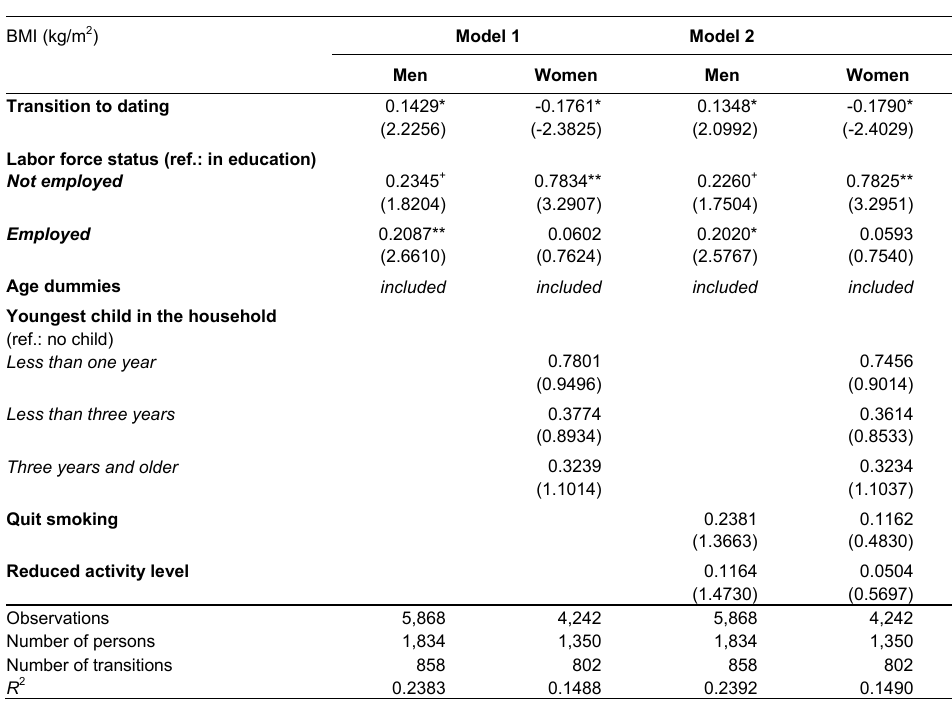
Fixed effects estimation results of transition to dating on